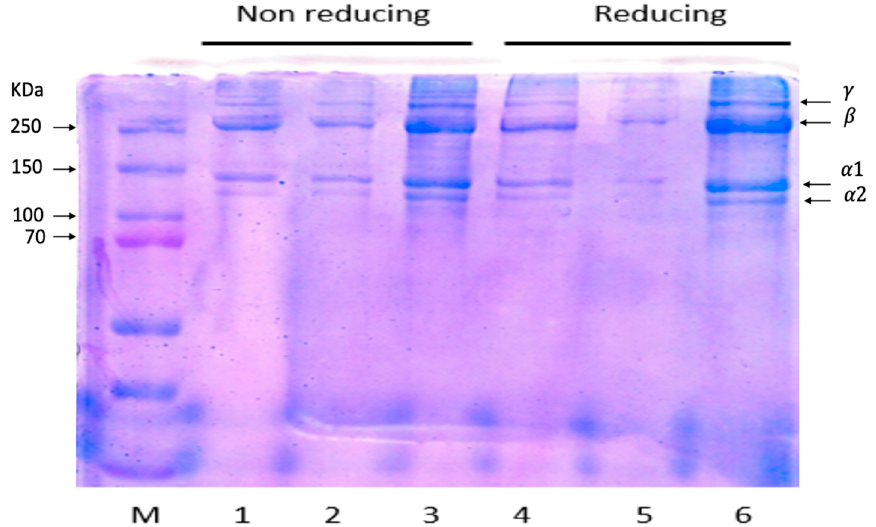
Figure 3. SDS-PAGE protein pattern of acids-soluble collagen for non-reducing and reducing conditions. Lane M: molecular weight marker; Lanes 1 and 4: acetic acid extraction (AAC); Lanes 2 and 5: lactic acid extraction (LAC); Lanes 3 and 6: citric acid extraction (CAC).